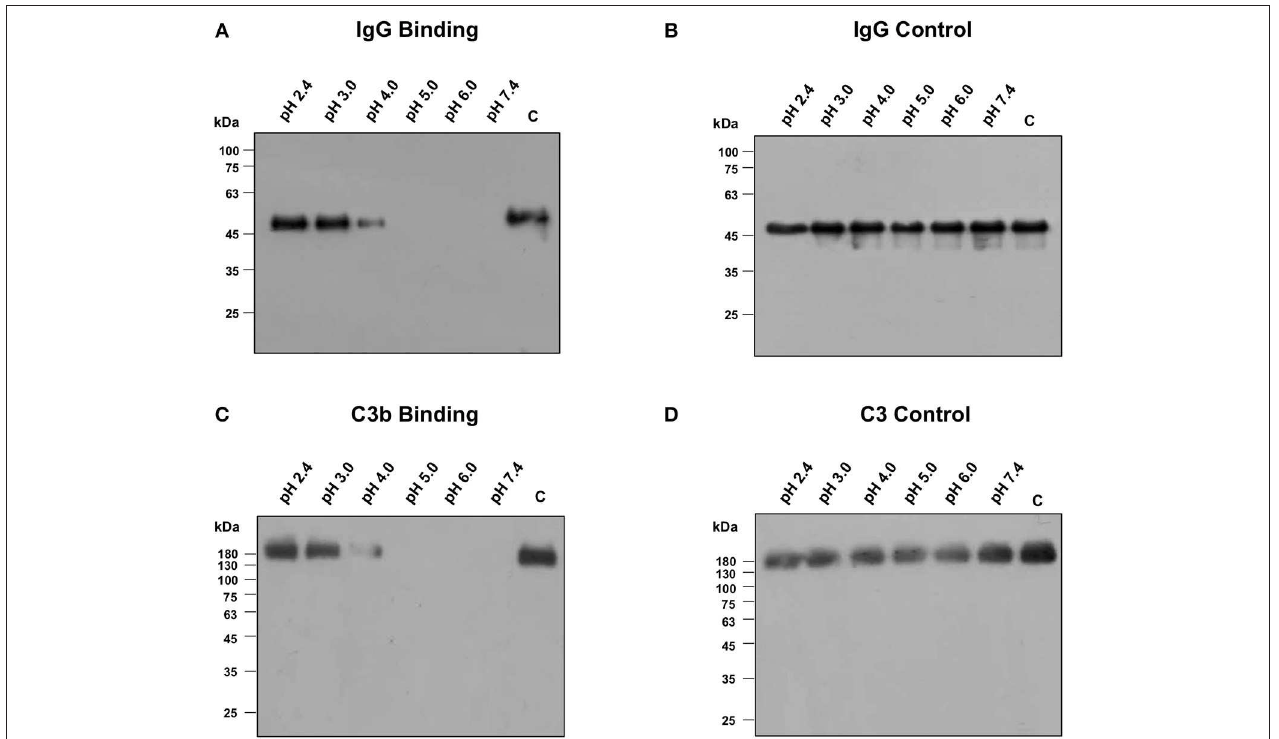
FIGURE 6 | Binding of IgG and C3b with encapsulated strain of Bacillus anthracis incubated at different pH buffers ranging from 2.4 to 7.4, supplemented with 10% normal human serum or 50 µ g/ml of purified human IgG. (A) Immunoblot assay for the detection of purified IgG binding on encapsulated strain of B. anthracis . IgG binding was observed at pH closer to the isoelectric point of poly- γ -D-glutamate (pI 3.2). (B) Purified IgG was stable at different pH buffers as detected by immunoblot. (C) Immunoblot assay for the detection of human C3b binding on encapsulated strain of B. anthracis . C3b binding was also observed at pH closer to the isoelectric point of poly- γ -D-glutamate. (D) Normal human serum (NHS) was incubated at different pH buffers and C3 was observed to be stable at low pH as analyzed by